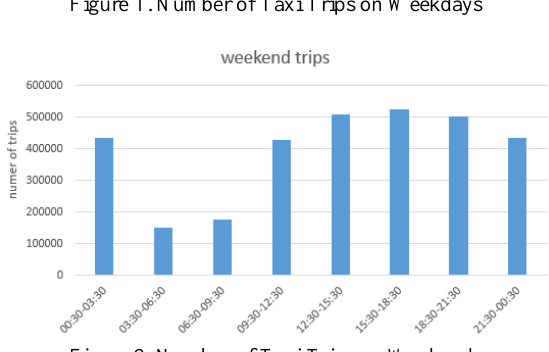
Figure 1. Number of Taxi Trips on Weekdays